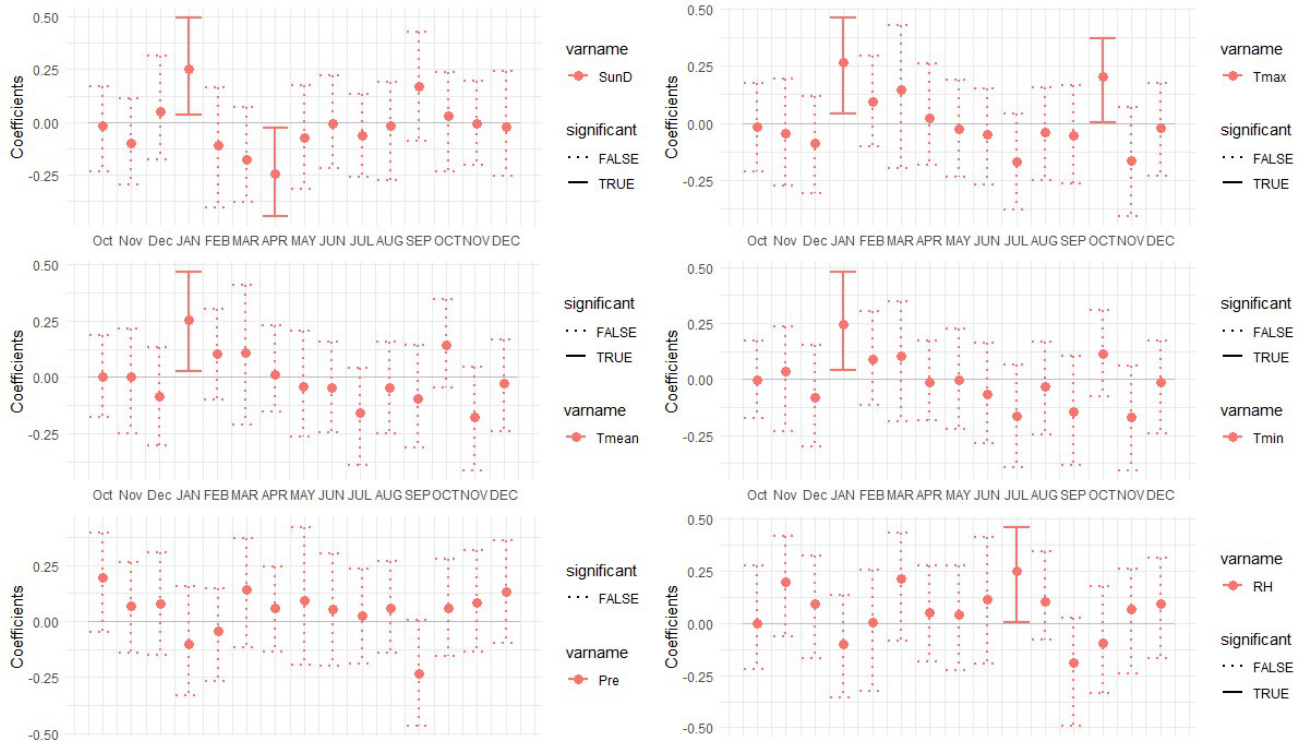
Figure A7. Correlation coefficient between TRW and climate during 1955–2014.